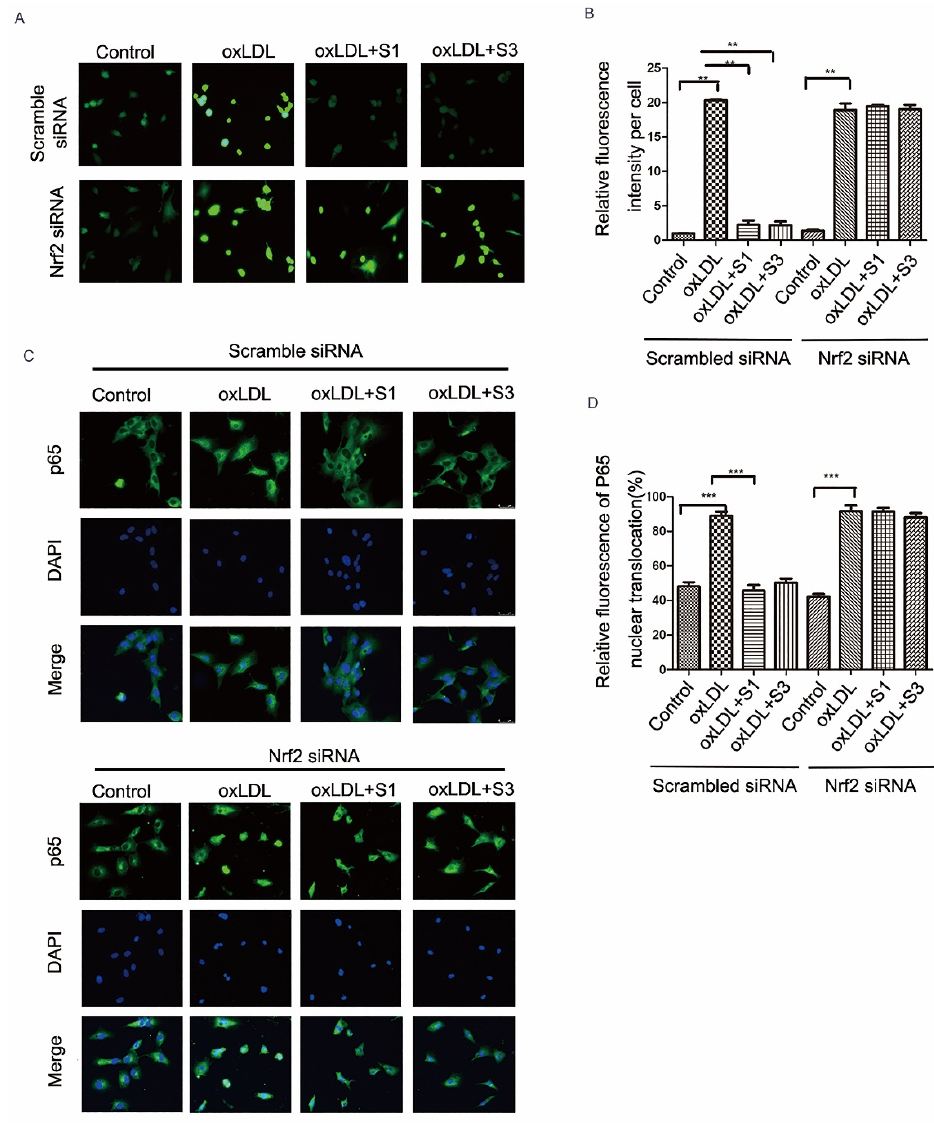
Figure 9. Effects of compounds S1 and S3 on the ROS production and the activation of NF- κ B in Nrf2-knockdown HUVECs. HUVECs were treated with 40 nM scramble siRNA or Nrf2 siRNA for 48 h and treated with oxLDL (50 µ g/mL) or oxLDL and indicated compound for up to 6 h. ( A ) The ROS level in HUVECs was examined by DCHF (100×). ( C ) Fluorescent micrographs showed the distribution of NF ‐κ B p65 in HUVECs (200×). ( B , D ) Quantification of intracellular ROS level and NF ‐κ B p65 nuclear translocation. Data were analyzed using one ‐ way ANOVA with Bonferroni correction. ** p < 0.01, *** p < 0.001 between indicated groups. n = 3.